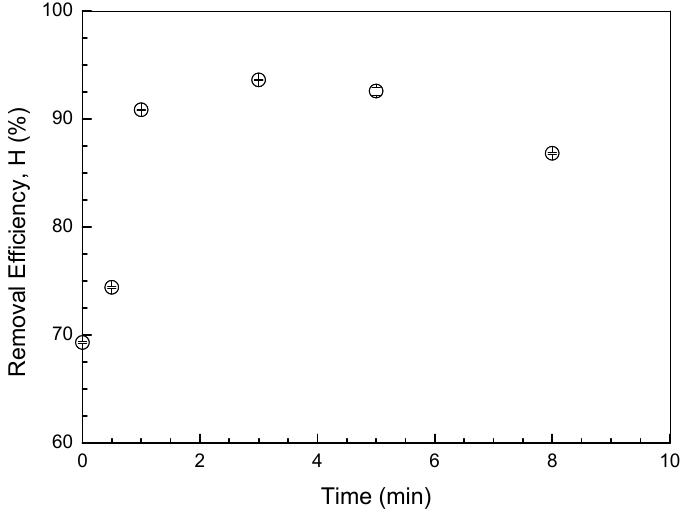
Figure 1. Dependence of RB5 removal efficiency on irradiation time.